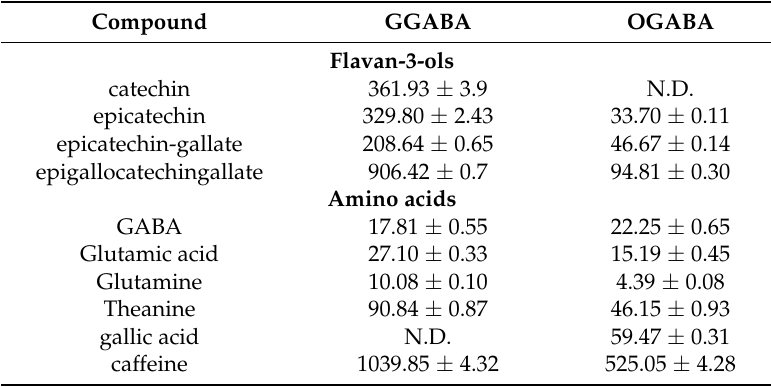
Table 5. Bioactive components concentration ( µ g/mL of tea beverage) in green GABA (GGABA) and OGABA extracts. Data are expressed as mean of three independent measurements ± standard deviation. N.D. = no